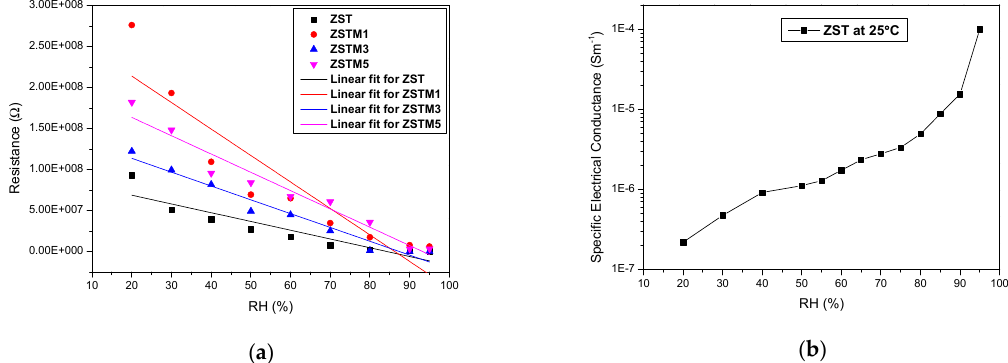
Figure 2. ( a ) Resistance change of the sensors versus relative humidity of 20% to 95% RH at room temperature fitted with the linear lines; ( b ) humidity dependency of the bulk electrical conductivity for humidity range of 20%–95% RH at room temperature for the ZST micro